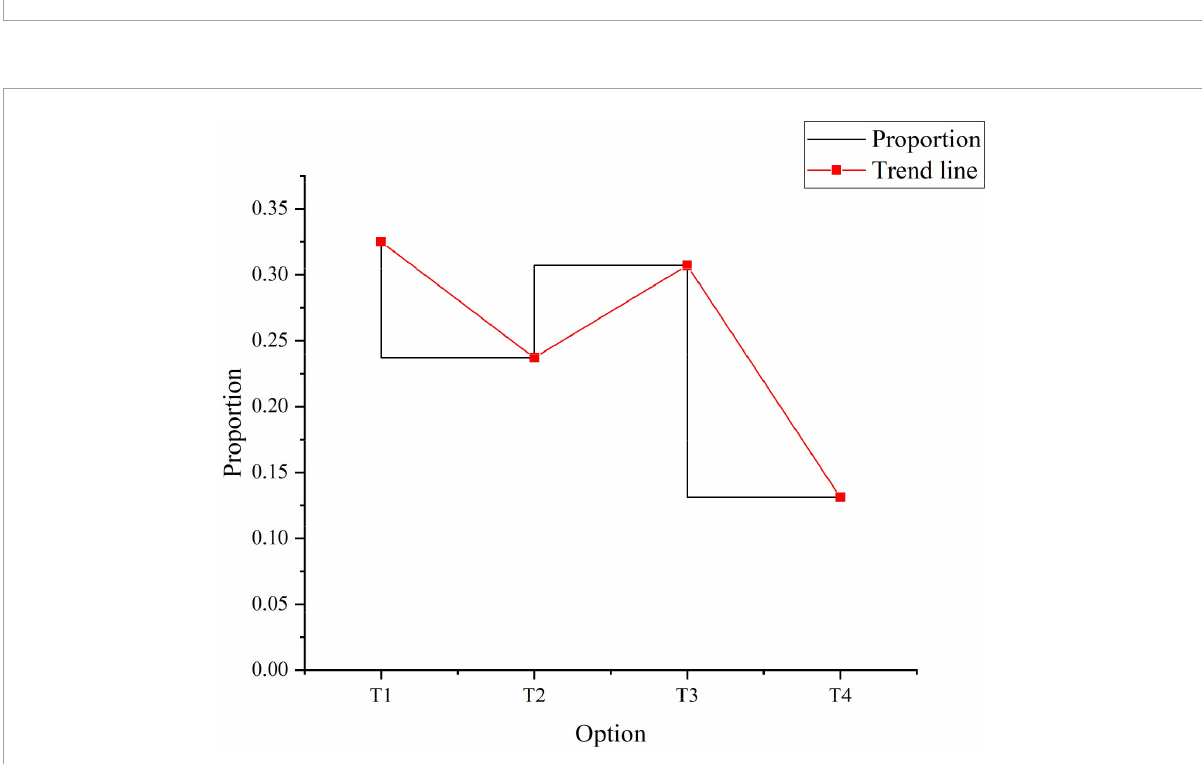
FIGURE5 The impact of entrepreneurial spirit on people. T1: it can improve personal accomplishment. T2: it can promote the construction of sports culture. T3: it can improve interest in sports culture construction. T4: